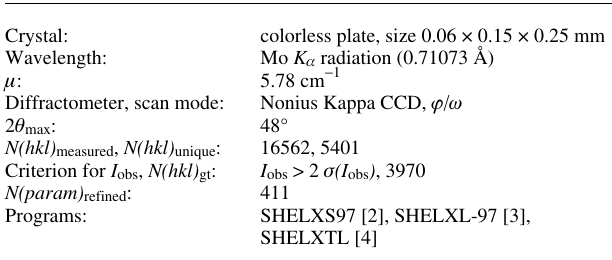
Table 1. Data collection and handling.